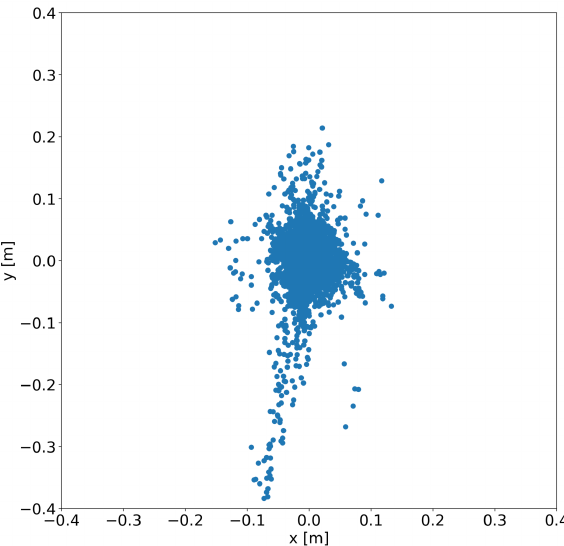
Figure 14. For the 2D ( x, y ) plane: Qualitative representation of the mean values of the consensus sets exceeding the 80 percent threshold.